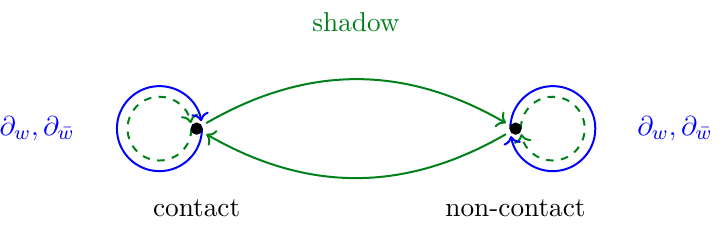
Figure 3 . Mapping between contact and non-contact terms under descendants (blue) and shadows (green). Both operations commute with the large- r expansion. The dashed maps between terms of the same type will be less relevant for what